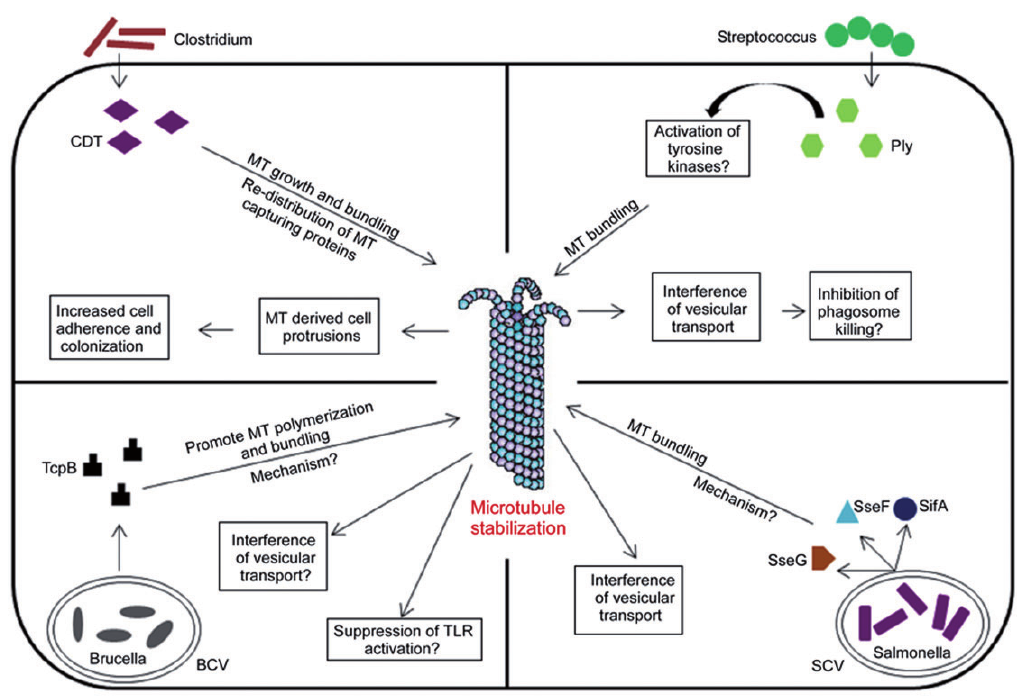
Figure 2 Bacterial effector proteins that stabilize host microtubules. The known mechanism of action of effector proteins and the benefi ts of host microtubule stabilization for the pathogen have been depicted in the fi gure. MT, microtubule; BCV, Brucella -containing vacuoles; SCV, Salmonella -containing vacuole; Ply, pneumolysin; CDT, Clostridium diffi cile